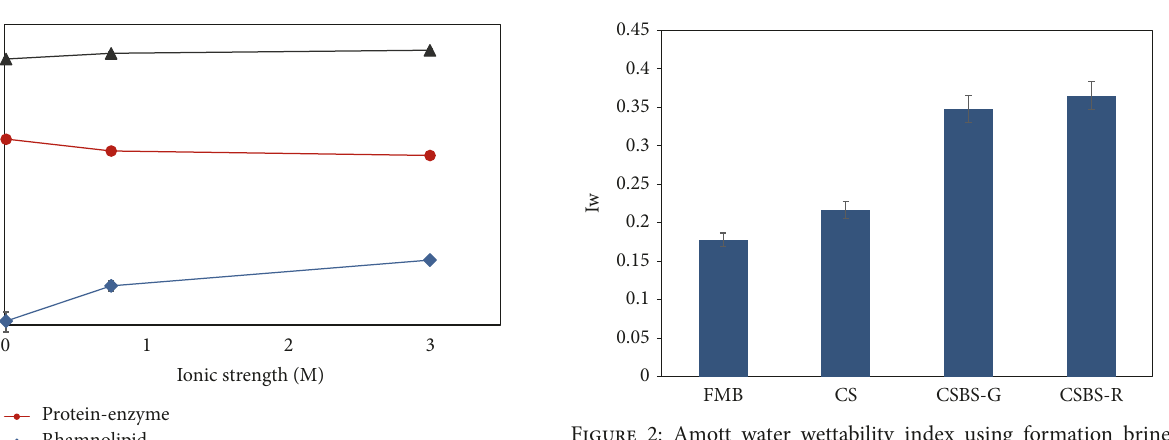
wettability index to water correspond to more water-wet